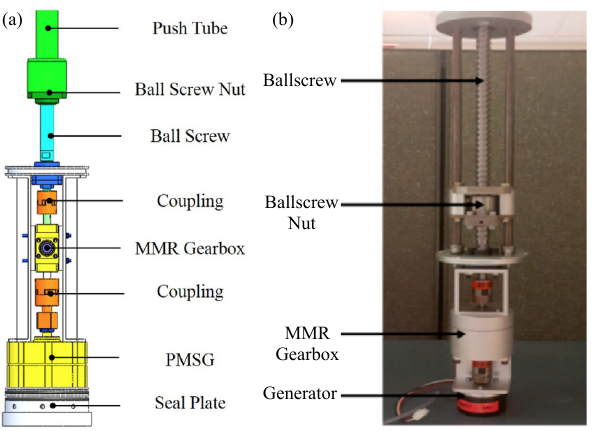
Figure 14. A ball screw mechanism is shown as an example to illustrate the working principle of the mechanical power take-off mechanism, with a schematic plot ( a ) and a mechanical motion rectifier ( b ), adapted from